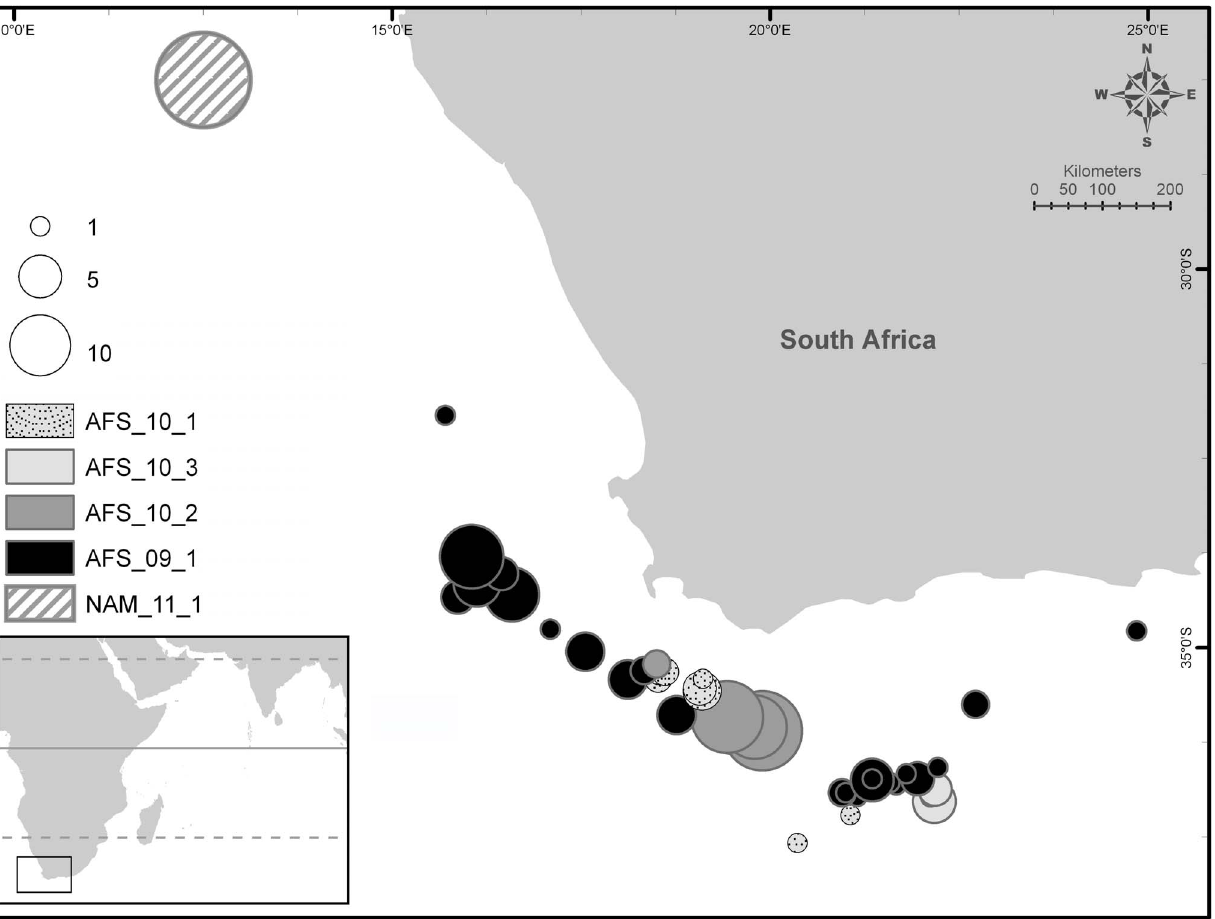
Figure 5. Sampling around South Africa and Namibia. Exact sampling size and location of the South Africa (AFS) and Namibia (NAM) sampling sets (see table 1 for details).